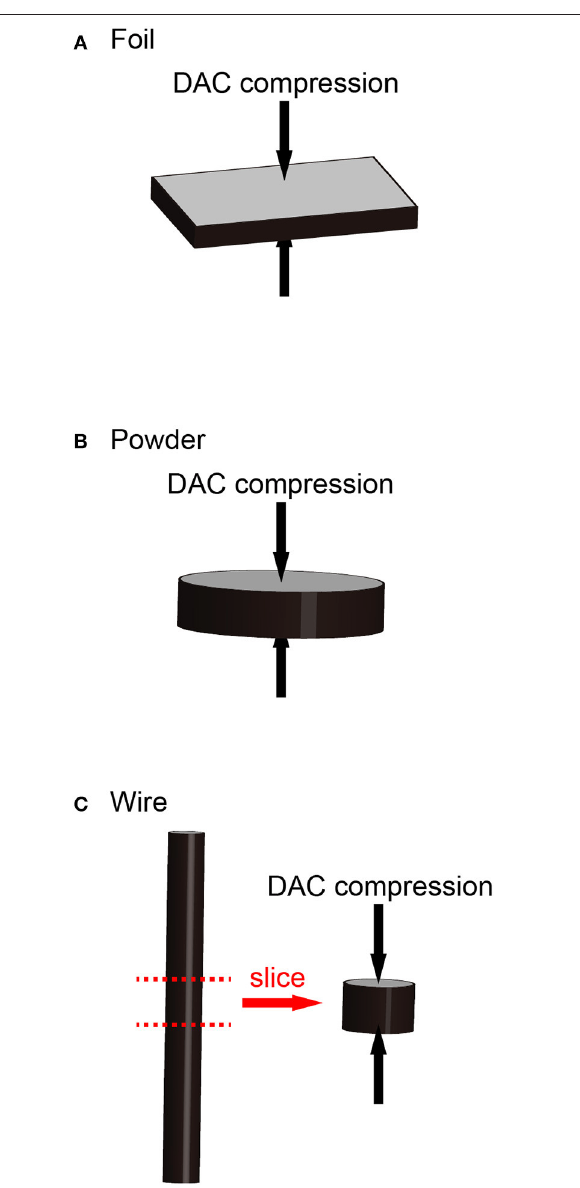
FIGURE 1 | Back-scattered electron (BSE) image of the bcc iron starting materials; (A) foil, (B) sintered and deformed powder, and (C) wire. These images were obtained using a scanning electron microscope equipped with a field emission gun (FE-SEM, JEO JSM-7000F) with accelerating voltage of 10 kV and probe current of 8 nA. Observed cross sections are normal to compression axis in the subsequent DAC experiments. Contrast in gray area is orientation contrast in iron whereas black dots in (B) are iron oxide.